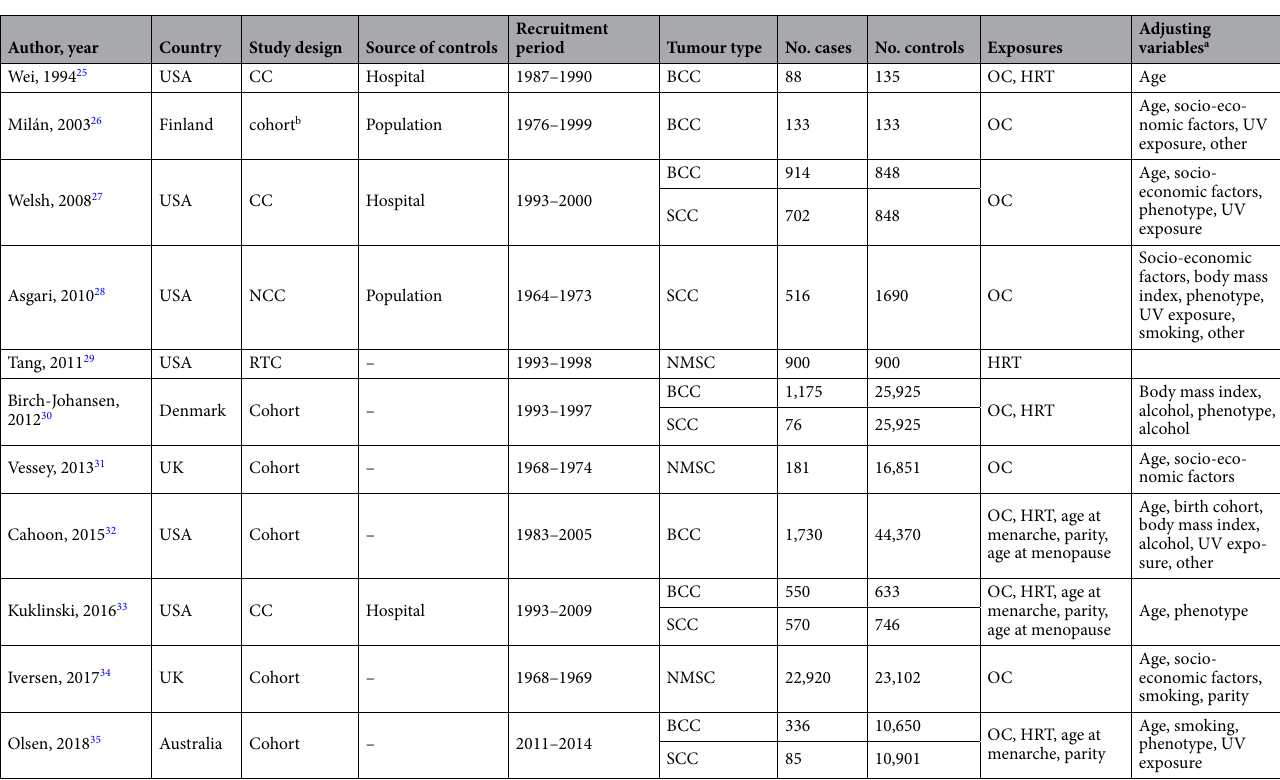
Table 1. Main characteristics of studies included in the review and meta-analysis on the association between use of exogenous sex hormones, menstrual and reproductive history, and risk of non-melanoma skin